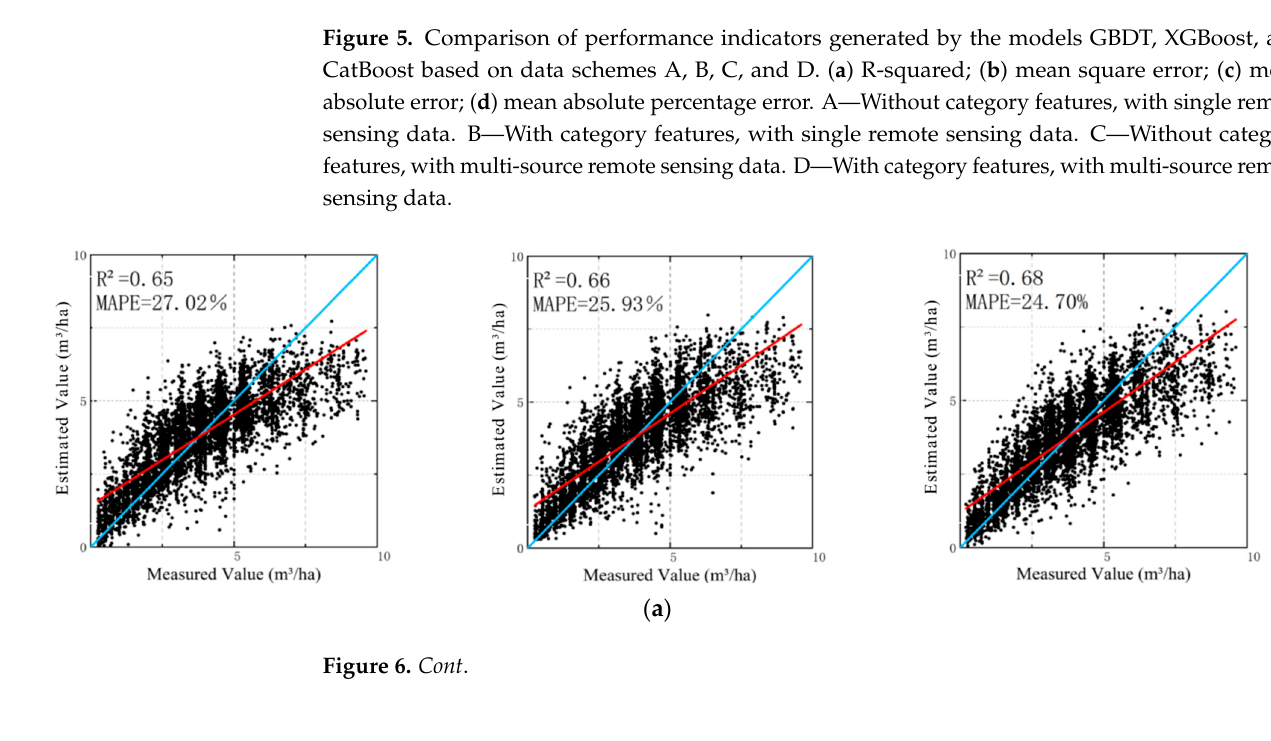
Figure 5. Comparison of performance indicators generated by the models GBDT, XGBoost, and Cat- Boost based on data schemes A, B, C, and D. ( a ) R-squared; ( b ) mean square error; ( c ) mean absolute error; ( d ) mean absolute percentage error. A—Without category features, with single remote sensing data. B—With category features, with single remote sensing data. C—Without category features, with multi-source remote sensing data. D—With category features, with multi-source remote sens- ing data.